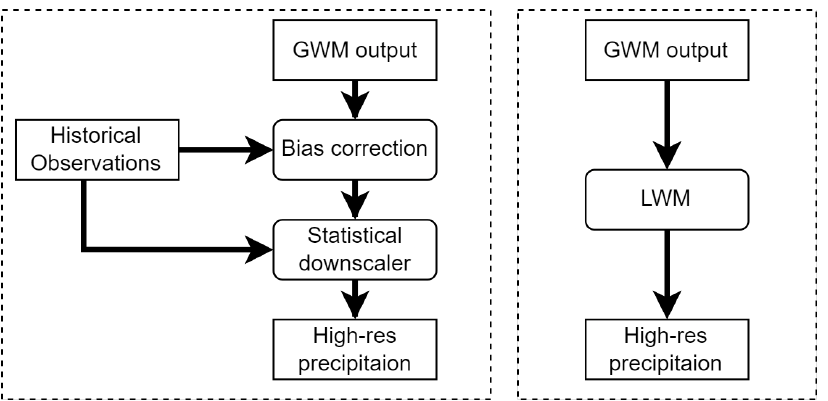
Figure 2. Flowchart of statistical downscaling ( left ) and dynamical downscaling ( right